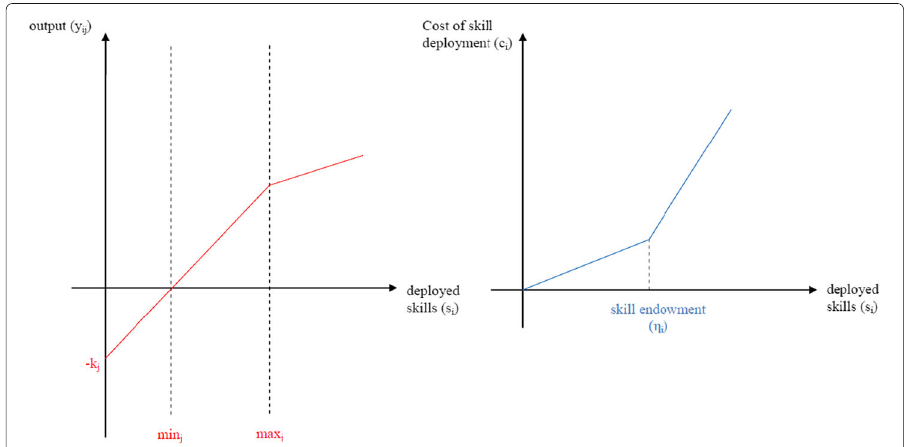
Fig. 5 Alternative production and cost